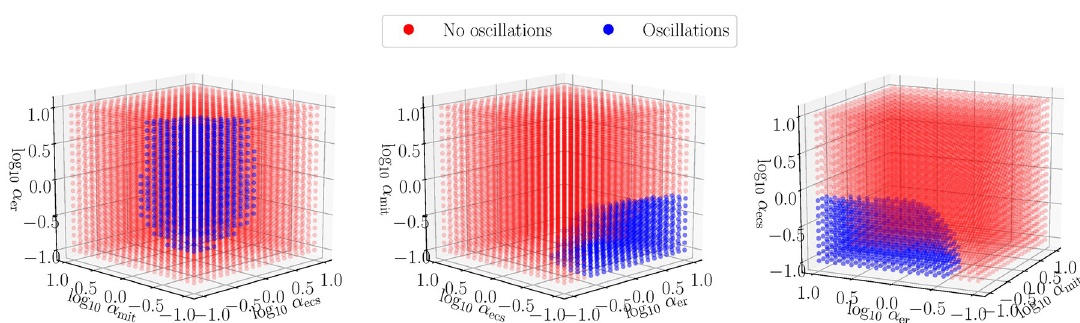
Fig 5. Presence of oscillations as a function of flux rescalings defined in Eq 34, rotations of axes shown for